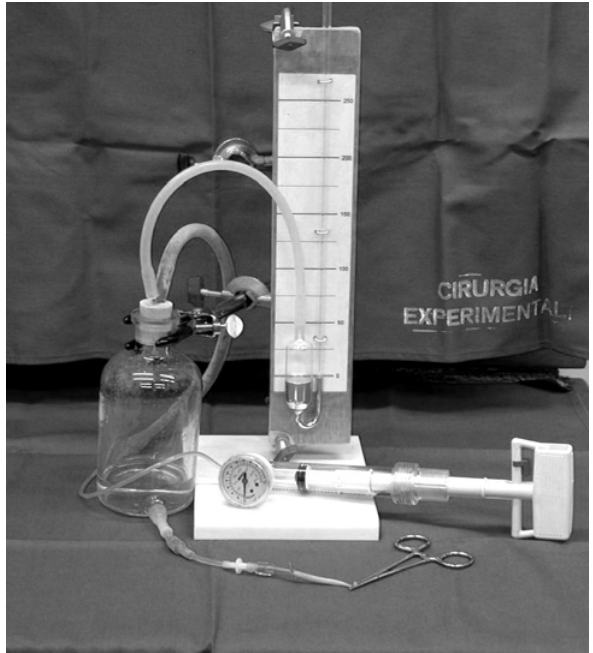
Fig. 1 - Padronização da pressurização das veias safenas